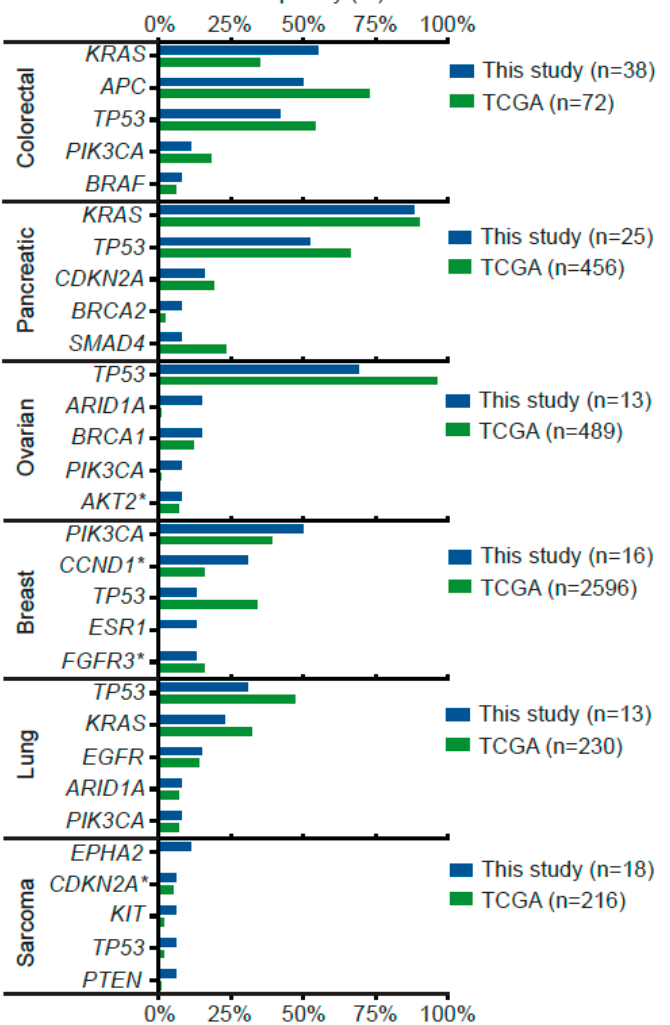
Figure 2. Most frequent gene alterations (top 5) by cancer type in our cohort versus TCGA cohorts. * Indicates copy number alteration, amplification or deletion.